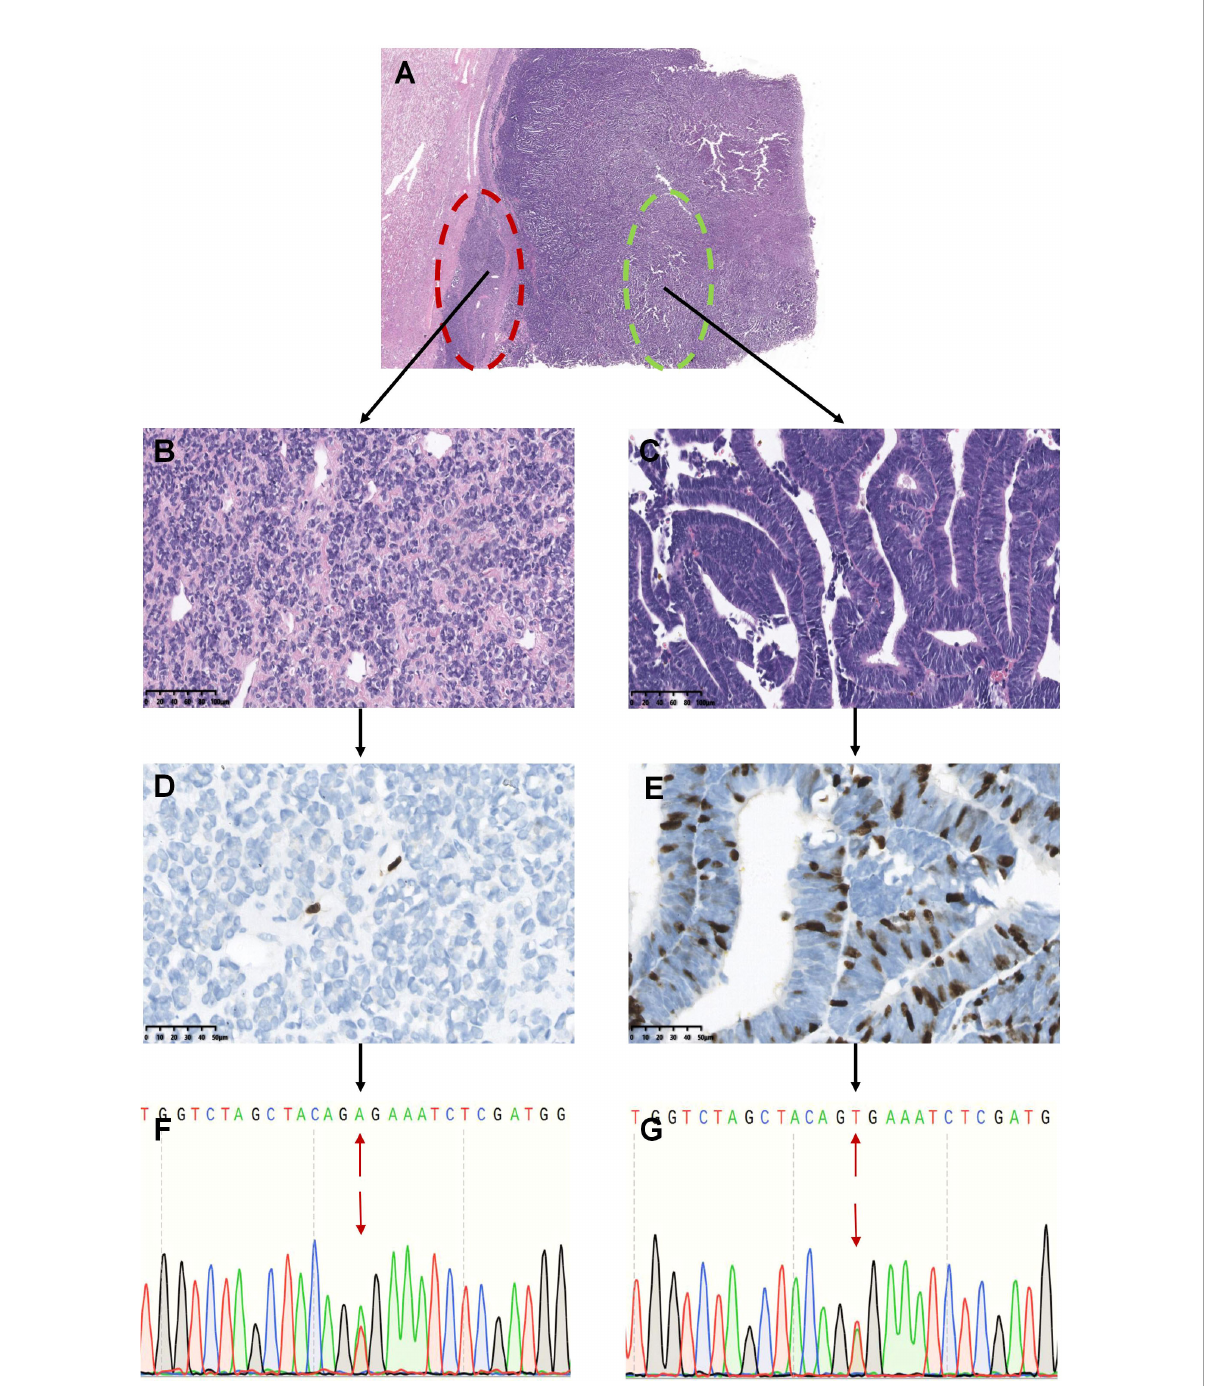
FIGURE 4 Analysis of BRAF mutations in different areas of renal tumors with overlapping morphology (Represented by case 37). The tumors showed overlapping morphological features of epithelial-predominant WT and MA (A) . The red circle indicates typical MA-like features with mild cells and hyalinized stroma, and the tumor cells were oval or polygonal and tightly packed in the solid and nested areas (B) . The green circle shows that the tumor consisted of primitive epithelial components with a papillotubular architecture, similar to epithelial WT. The tumor cells were tall columnar, with fi ne chromatin, a high nucleocytoplasmic ratio, crowded high columnar nuclei, and minimal mitotic activity (C) . Only a few cells expressed Ki-67 in the typical MA-like areas (D) , whereas more Ki-67 was expressed in the epithelial WT-like areas (E) . Tumor cells from both areas showed the BRAF V600E mutation (F, G)